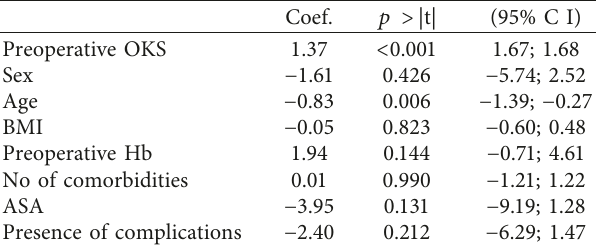
Table 6: Correlation between the preoperative data and postop- erative OKS. The preoperative KOOS was positively associated with the postoperative KOOS, while age was negatively associated. Coef.